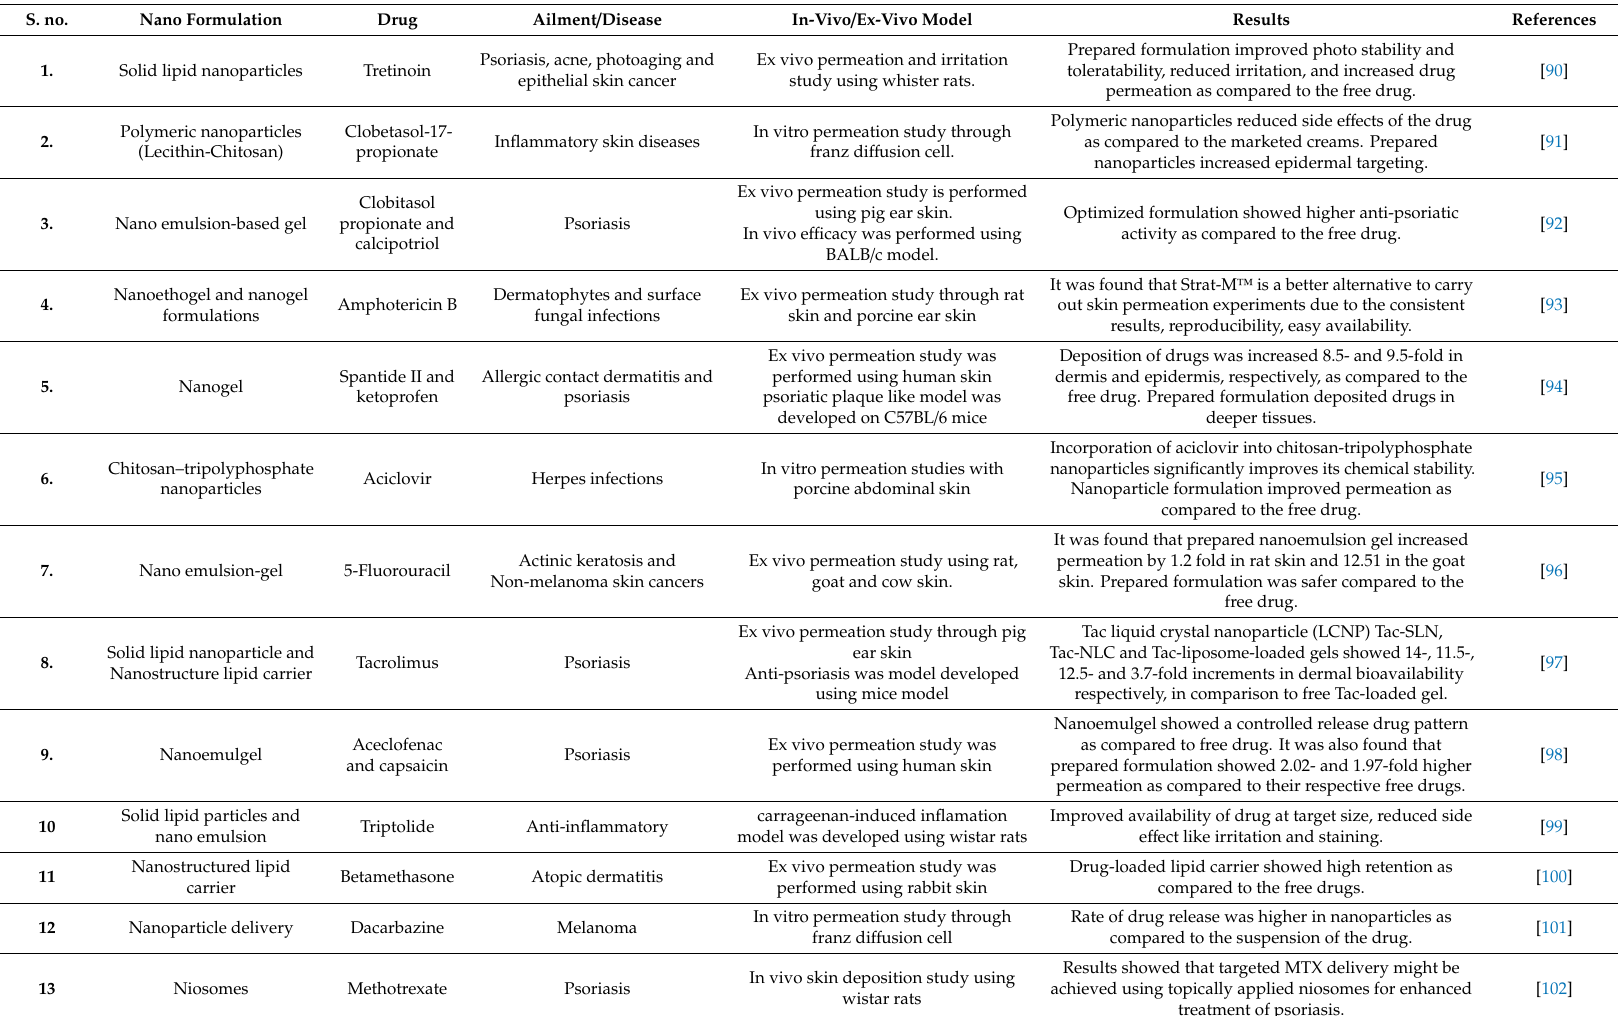
Table 3. Reported topical nanoformulations used in the treatment of various skin